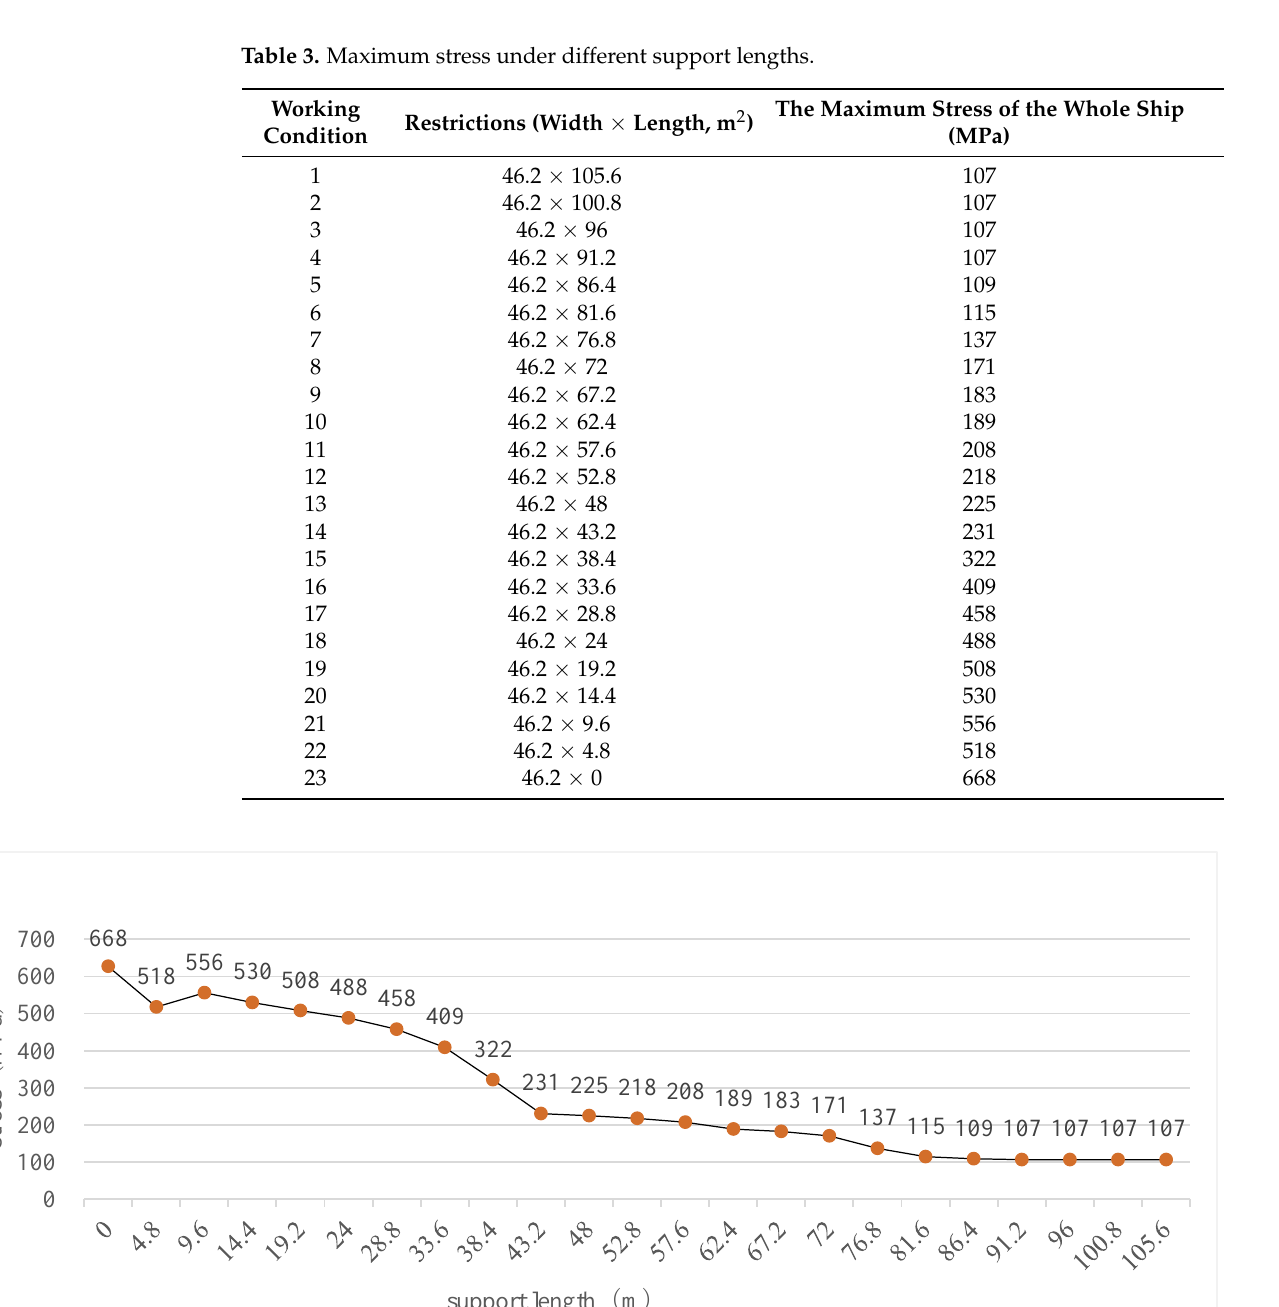
Figure 12. Maximum stress at different support lengths.